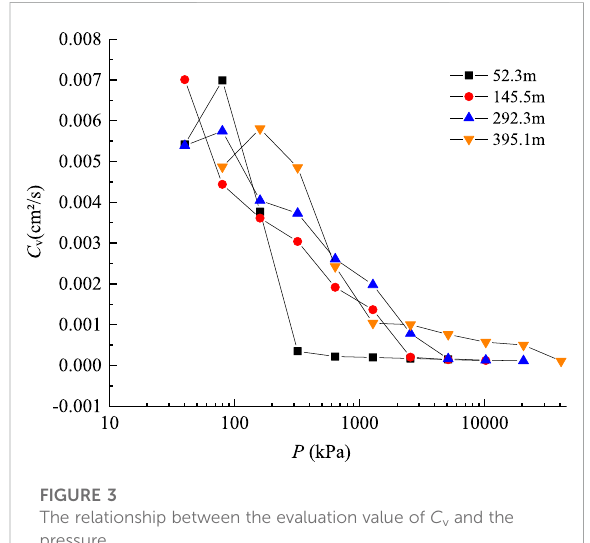
FIGURE 3 The relationship between the evaluation value of C v and the